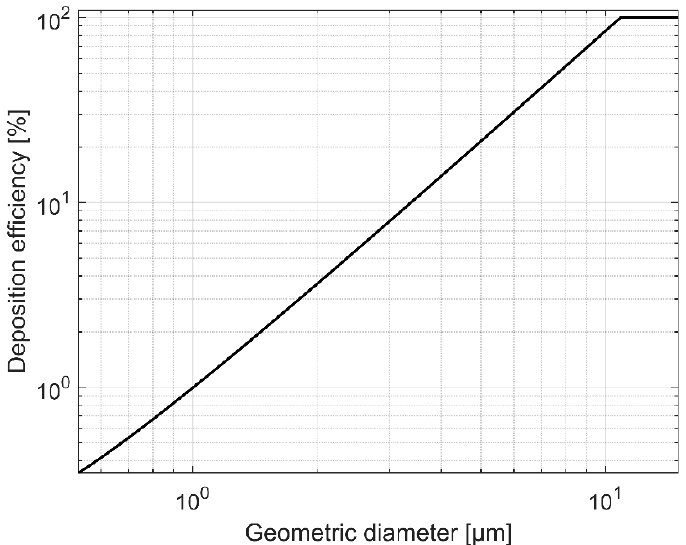
Figure A1. Calculated deposition efficiency [%] in the ALI exposure system as a function of particle geometric diameter (µm).